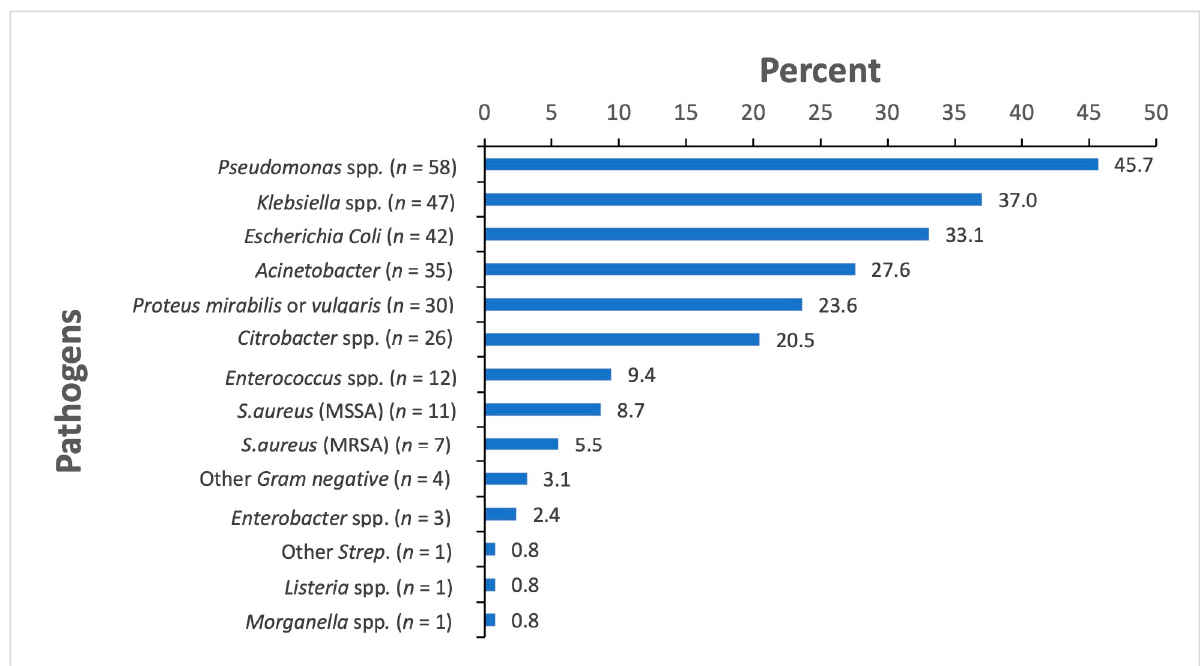
Figure 2. The bacteria isolated in blood cultures, n = 31. Figure legend: n denotes the number of patients with a positive blood culture for bacterial pathogens.